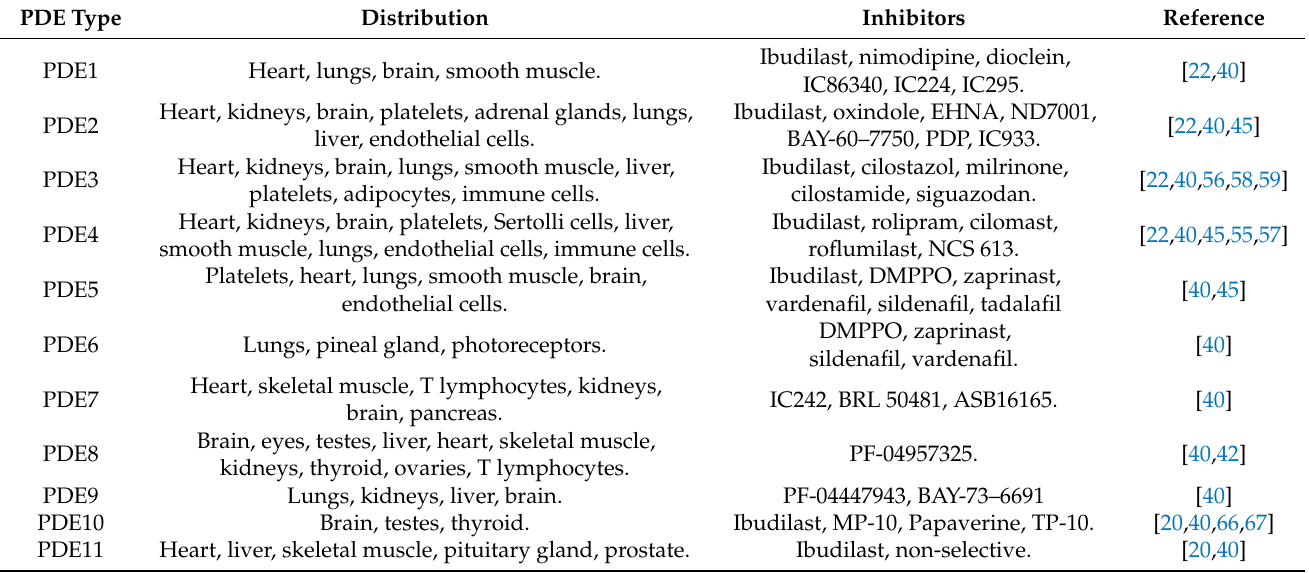
Table 1. Different PDE families, their tissue and organ distribution and their main inhibitors, focusing on those mentioned in the main